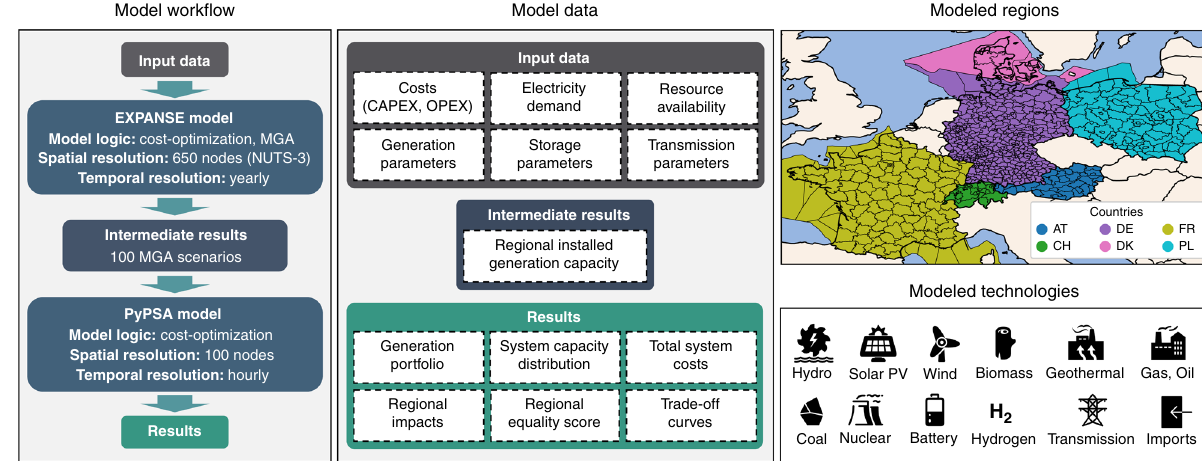
Fig. 8 Overview of model work fl ow, data, regions and technologies. MGA modeling to generate alternatives; NUTS-3 third-level nomenclature of territorial units for